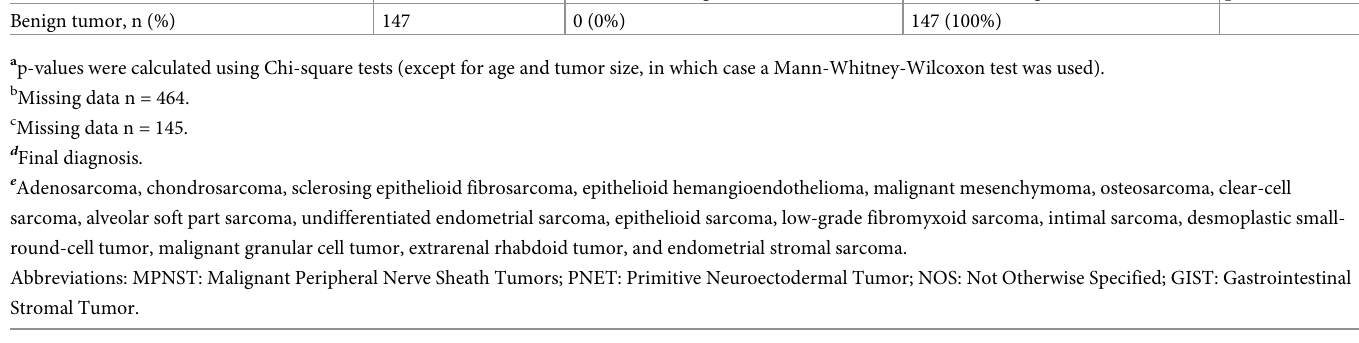
unit costs and the prices used for the pathway calculations are reported in Table 6. The costs are detailed in Table 7. • Probability calculations (step 3): The estimated probabilities based on the number of concor- dant and misdiagnoses according to the category of tumor are derived from Table 3. Moving left to right on the decision tree, the first probabilities showed the probabilities of the initial diagnosis for each category of tumor (e.g. the probability of having an initial diagnosis of